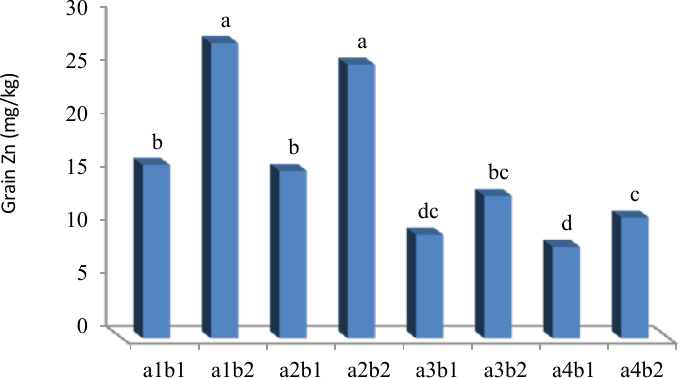
considered as significant